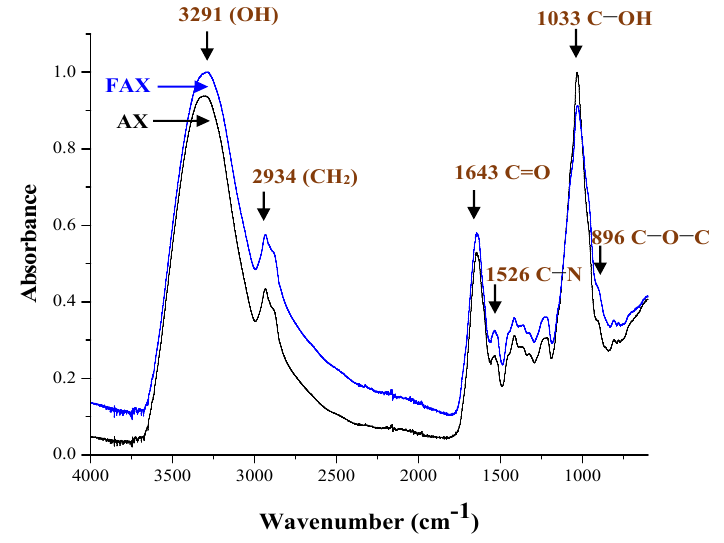
Figure 3. FTIR spectra of AX and FAX.